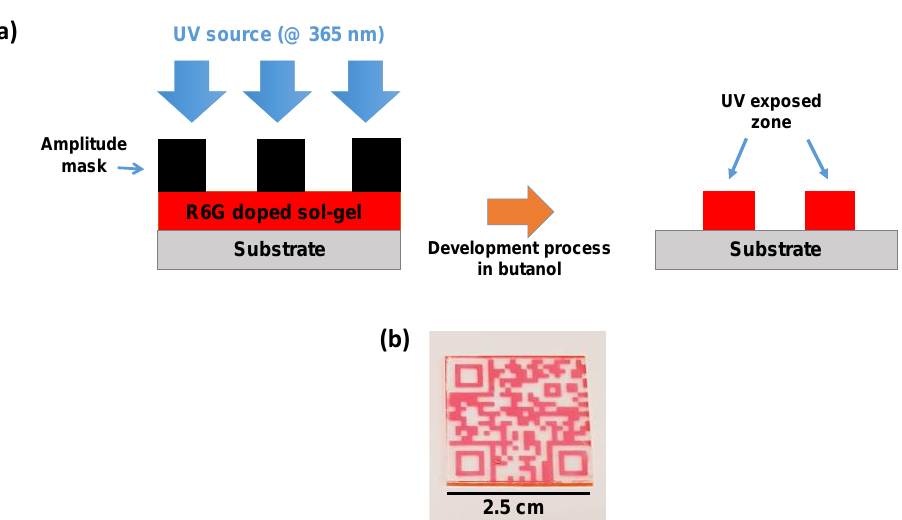
Figure 2. Example of photolithography process. ( a ) Photomask lithography technique on R6G TiO 2 - SiO 2 sol-gel layers. ( b ) Picture of a pattern (QR-code) that can be achieved using the UV photomask approach. The red part corresponds to the UV exposed part and is still present after development in a butanol solution. All the doped layers are exposed to UV photons (365 nm) at 180 J/cm 2 . The layers were characterized in terms of PL via a Horiba Jovin Yvon confocal mi- crospectrometer (Longjumeau, France) using a He-Cd laser operating at 442 nm (2.81 eV) and an Argon ion (Ar + ) laser providing photons at 488 nm (2.54 eV), where their respective powers can be adjusted using filters from 0.01% to 100% of the total laser power. For